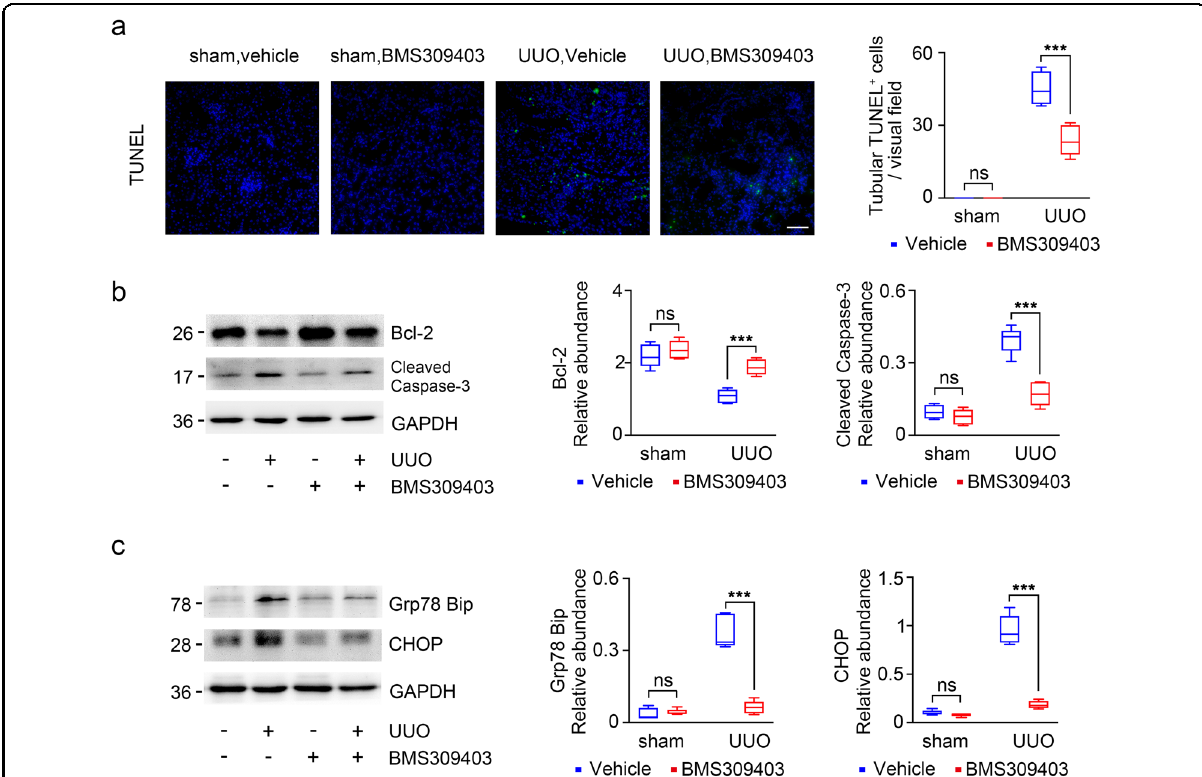
Fig. 7 Apoptosis and ER stress were signi fi cantly ameliorated in UUO kidneys after BMS309403 treatment. a TUNEL staining of kidney tissues (green: TUNEL-positive cells). b Western blot of whole-kidney lysates for Bcl-2, cleaved caspase-3 expression in mice. GAPDH sets as loading control. c Western blot of whole-kidney lysates for Grp78 (Bip), CHOP expression in mice. GAPDH sets as loading control. Representative images from three independent experiments are shown above. *** P < 0.001, ns means no statistical signi fi cance. Scale bars: 50 μ